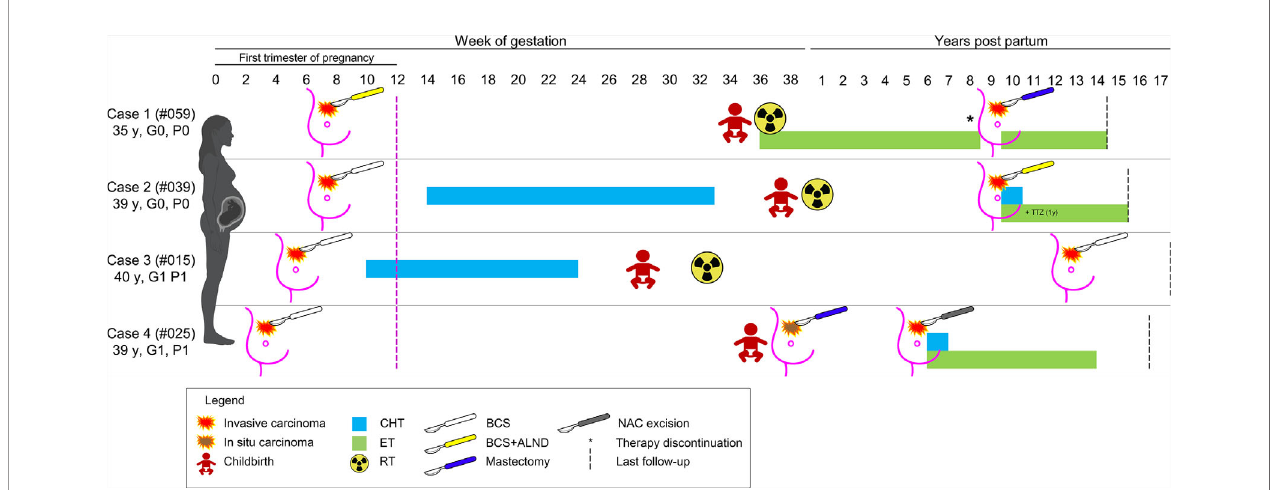
FIGURE 2 | Schematic representation of the clinical history of the four patients with a diagnosis of breast cancer during pregnancy that experienced a secondary event after breast-conserving surgery. The timeline depicts the weeks of gestation and the years after childbirth, as reported on the top; patients are shown as rows, according to their ID and obstetric history on the left; the type of therapy is coded based on the legend on the bottom. CHT, chemotherapy; ET, endocrine therapy; RT, radiation therapy; TTZ,